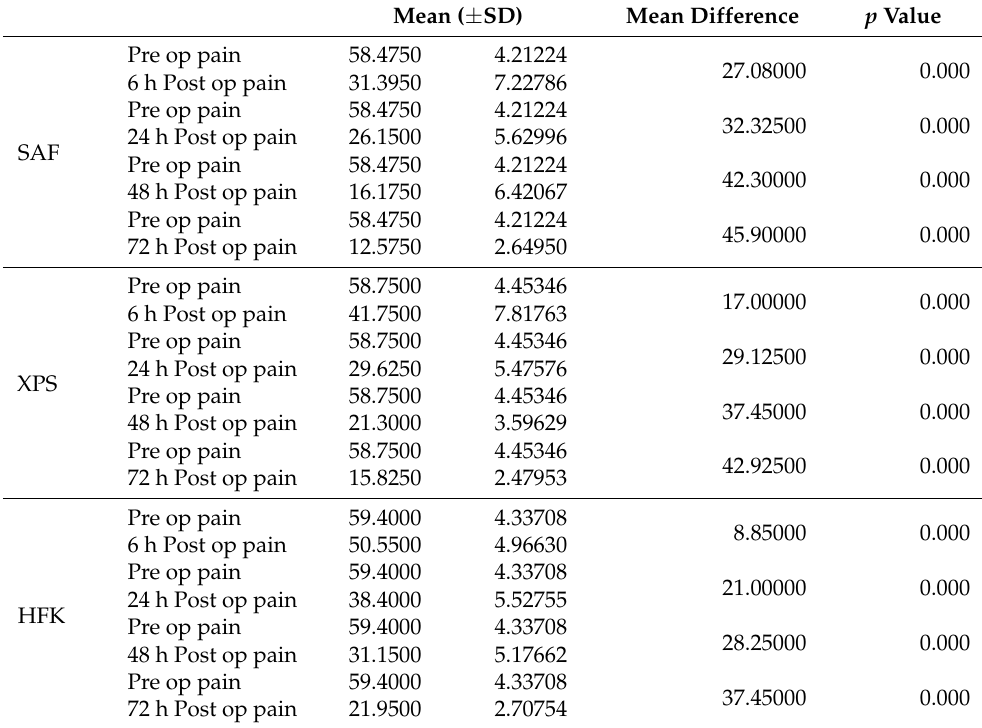
Table 2. Pre-operative and post-operative pain. Mean VAS scores ( ± SD).